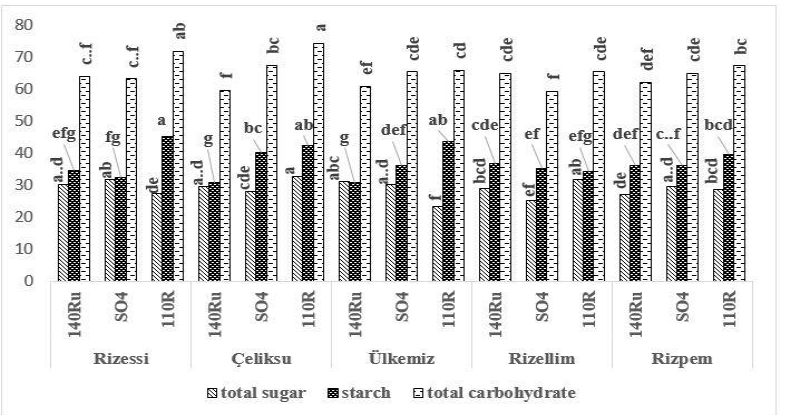
Figure 3. Under the graft area (rootstock) carbohydrate accumulations in grafted vine saplings. total sugar p < 0.01 LSD: 3.41, starch p < 0.01 LSD: 4.14, total carbohydrates p < 0.01 LSD: 5.01. a – g: differences between results shown with different letters in the same designs are statistically significant.